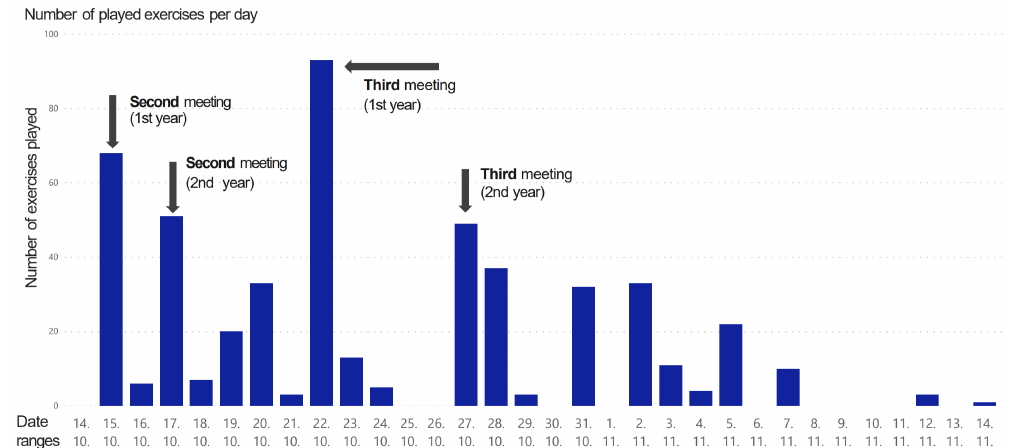
Figure 6. Graph of the application’s usage frequency per day. The second and third meetings are marked individually for each test group. The engagement the day after the meeting (# of exercises) was initially low after the meeting with both the first- and the second-year students. However, it increased after the second